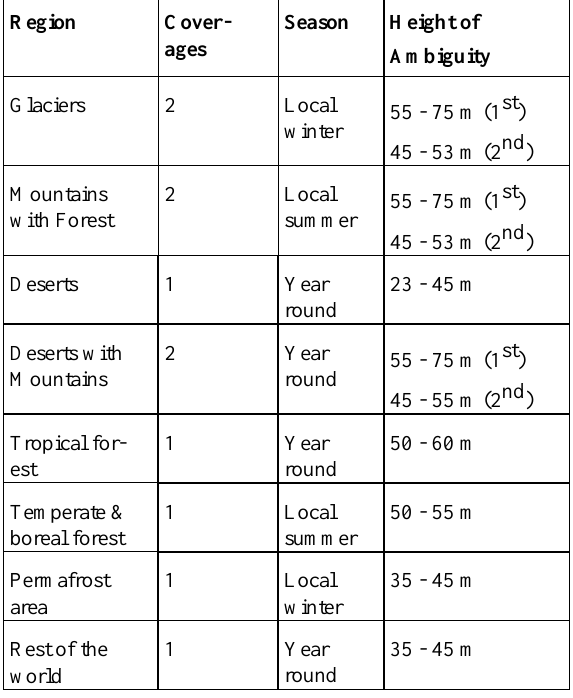
Table 3. Acquisition parameters for the Change DEM Product. These constraints reflect the lessons learned from the processing of the TanDEM-X DEM, where a number of disadvantages of the used acquisition strategy had to be faced. Many of these disadvantages could be reverted by dedicated additional acquisitions. The following list shows some of these lessons